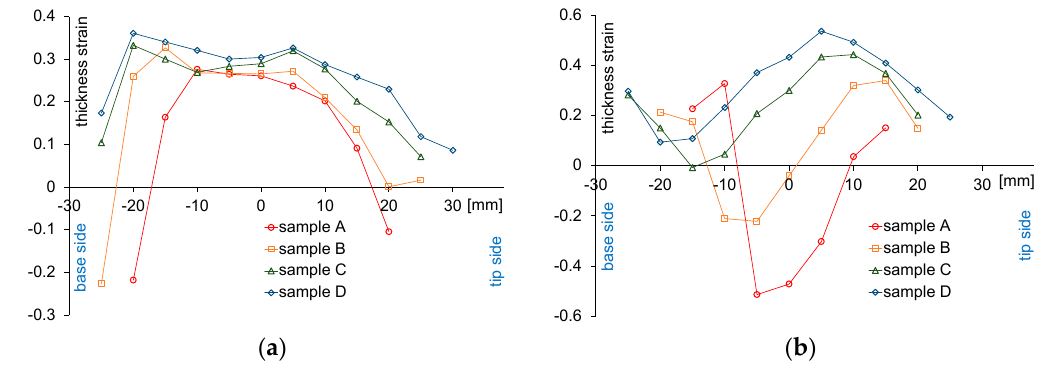
Figure 10. Distribution of thickness strain in the axial direction. ( a ) Outer and ( b ) inner sides of the curve. The horizontal axis represents the distance in the axial direction. The origin of the horizontal axis is at the middle cross section perpendicular to the spindle axis.